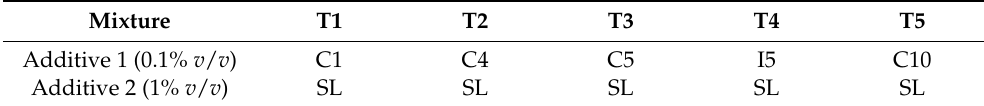
Table 1. The mixing formulas of compound